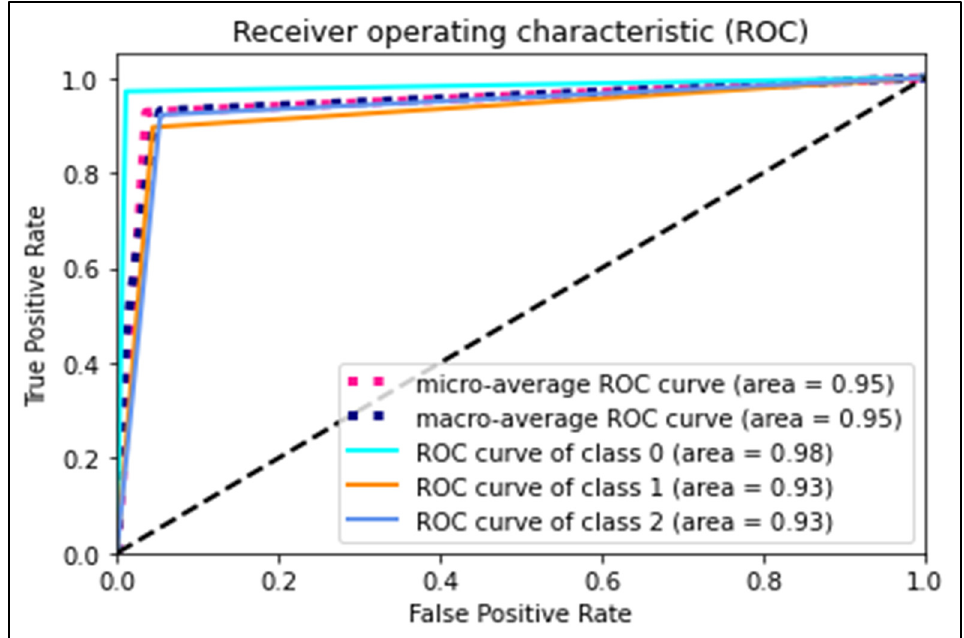
positive class curve (1) and negative class curve (2). Overall, the ROC curve for the CNN Figure 13. Confusion matrix of CNN algorithm for Riyadh dataset (before COVID-19) dataset. classifier denoted that the classifier performed well.